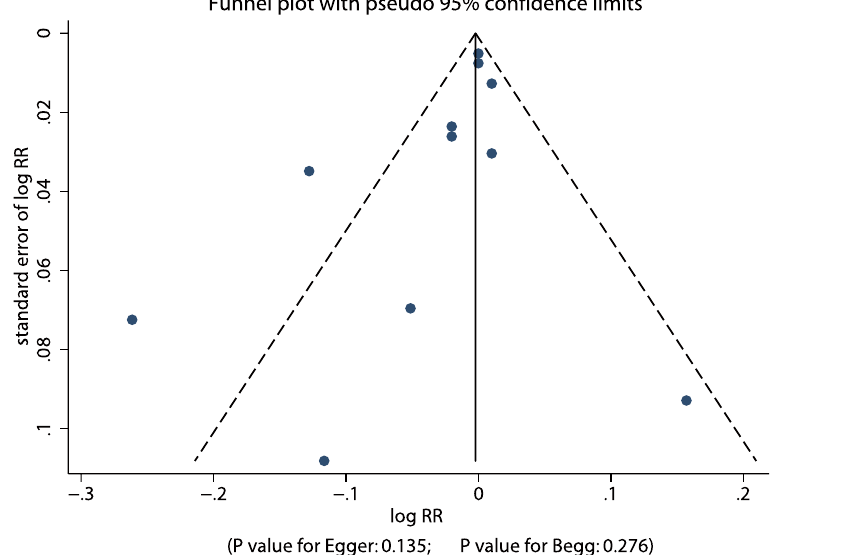
Figure 5. Funnel plot for high versus low PUFA intake for lung cancer (A); Funnel plot for per 5 g/day increment in PUFA intake for lung cancer (B). risk of lung cancer. This large quantitative study included meta-analysis suggest that increased PUFA intake had little or 1,268,442 individuals from 8 prospective cohort studies with a no effect on the incidence of lung cancer. To the best of our knowledge, this is the first time a meta-analysis has evaluated, broad range of populations. The findings from our current